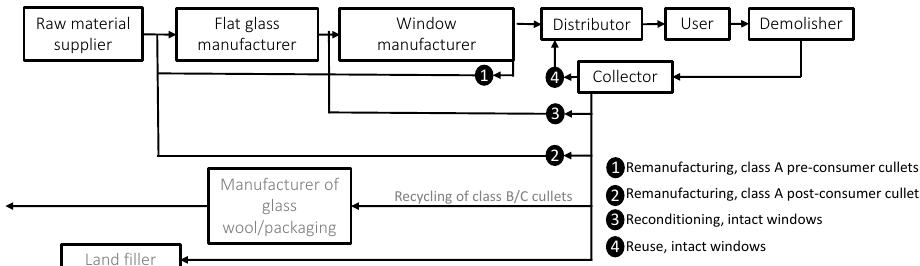
Figure 2. The four CLSCs identified for flat glass.